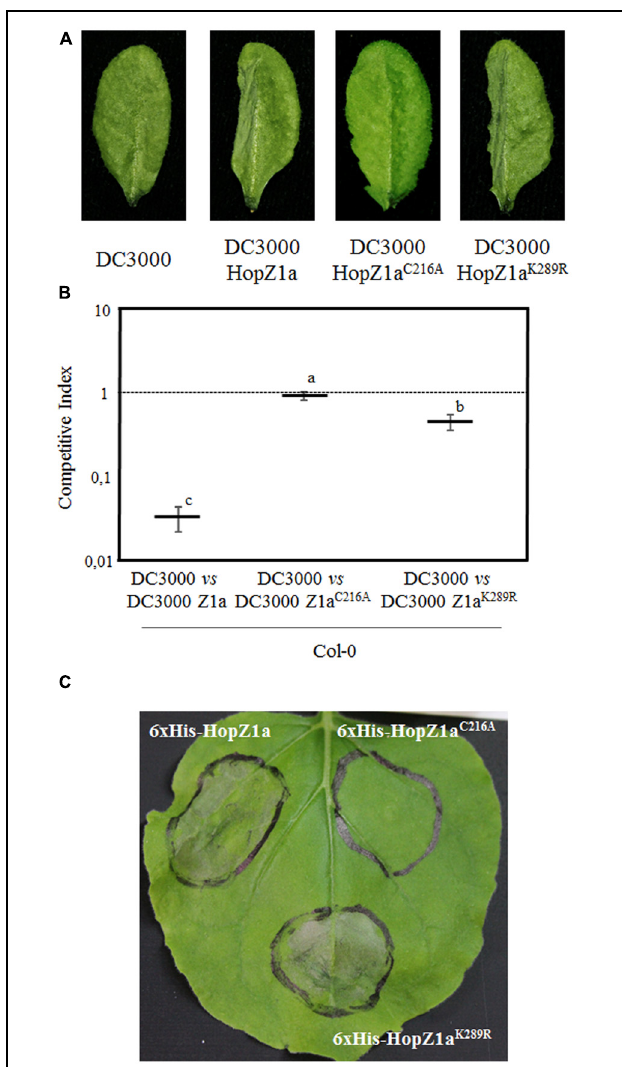
FIGURE 5 | HopZ1a K289R triggers ETI. (A) Hypersensitive response (HR) to hand-infiltration of Col-0 leaves with bacterial suspensions containing 5 × 10 7 cfu/ml of DC3000 alone or DC3000 expressing HopZ1a (pAME30), or each of its mutant derivatives HopZ1a C216A (pAME27) or HopZ1a K289R (pMAM1). Photographs were taken 24 h post-inoculation. Images are representative of at least 30 inoculated leaves per strain and experiment. The experiment was repeated twice with similar results. (B) Competitive indices (CIs) measuring growth within a mixed infection of DC3000 expressing HopZ1a (Z1a, pAME30), or each of its mutant derivatives HopZ1a C216A (Z1a C216A , pAME27) or HopZ1a K289R (Z1a K289R , pMAM1), in relation to growth of DC3000. CIs are calculated as the output ratio between the strain expressing the effector and DC3000, divided by their input ratio. Each CI value represents the means of three independent experiments with three biological replicates each. Error bars represent the standard error. Mean values marked with the same letter were not significantly different from each other as established by Student’s t -test ( P < 0.05). (C) Development of